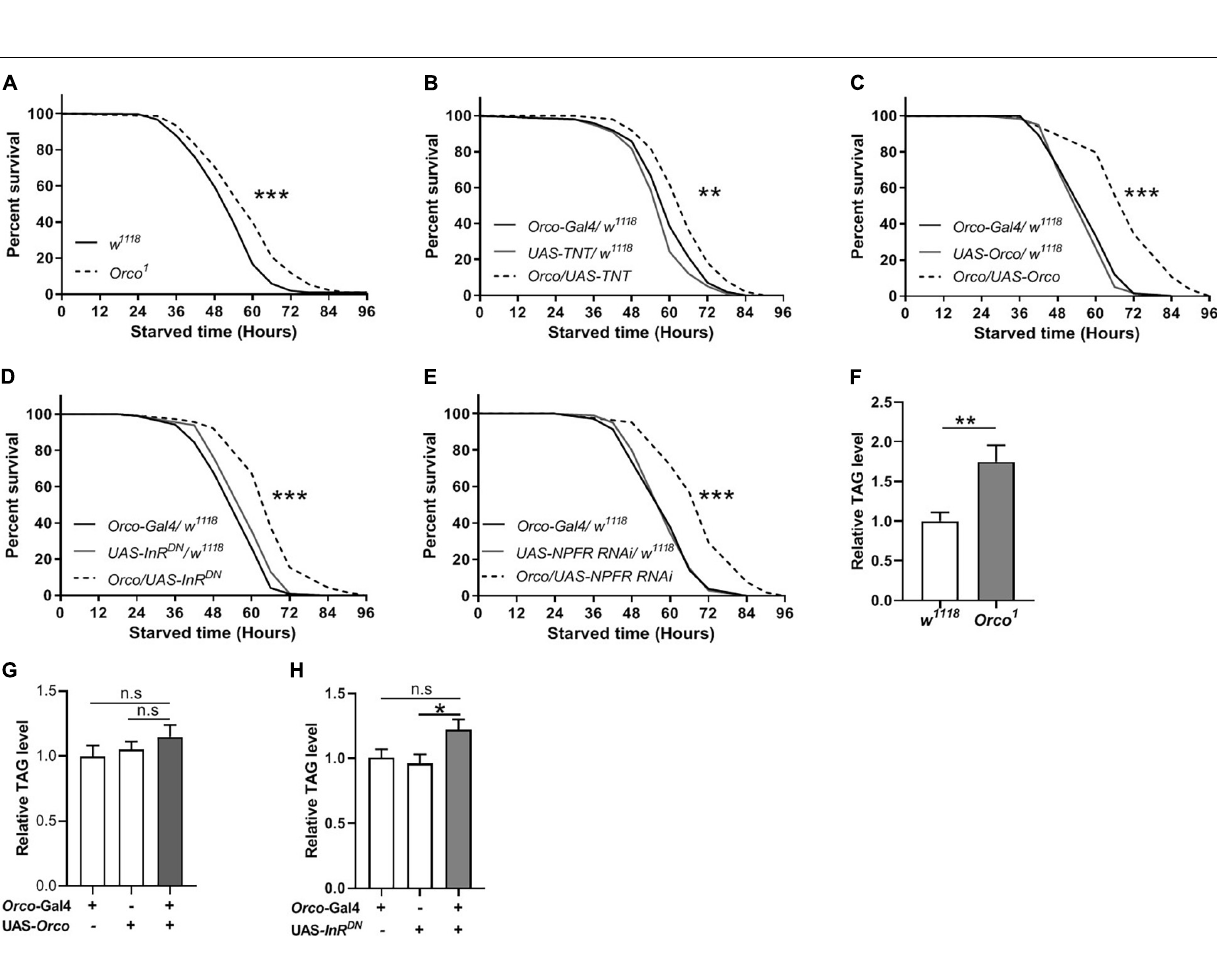
Frontiers in Behavioral Neuroscience |